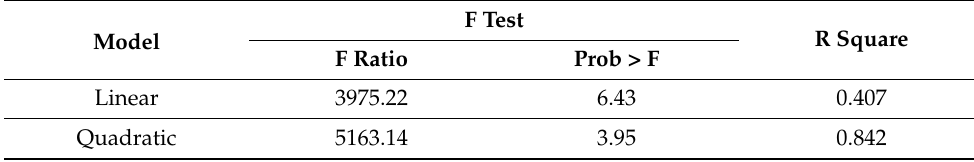
Figure 4. Effect of pH and temperature, aeration, and agitation rates on measured purified r-TBL-1 yield using G65 as the carbon source. Maximum and minimum values obtained from ( A ) purified rTBL-1 values, ( B ) kLa , ( C ) dry cell weight. Measured at 1000 rpm and 1 vvm of operation for G65 in fed-batch system.